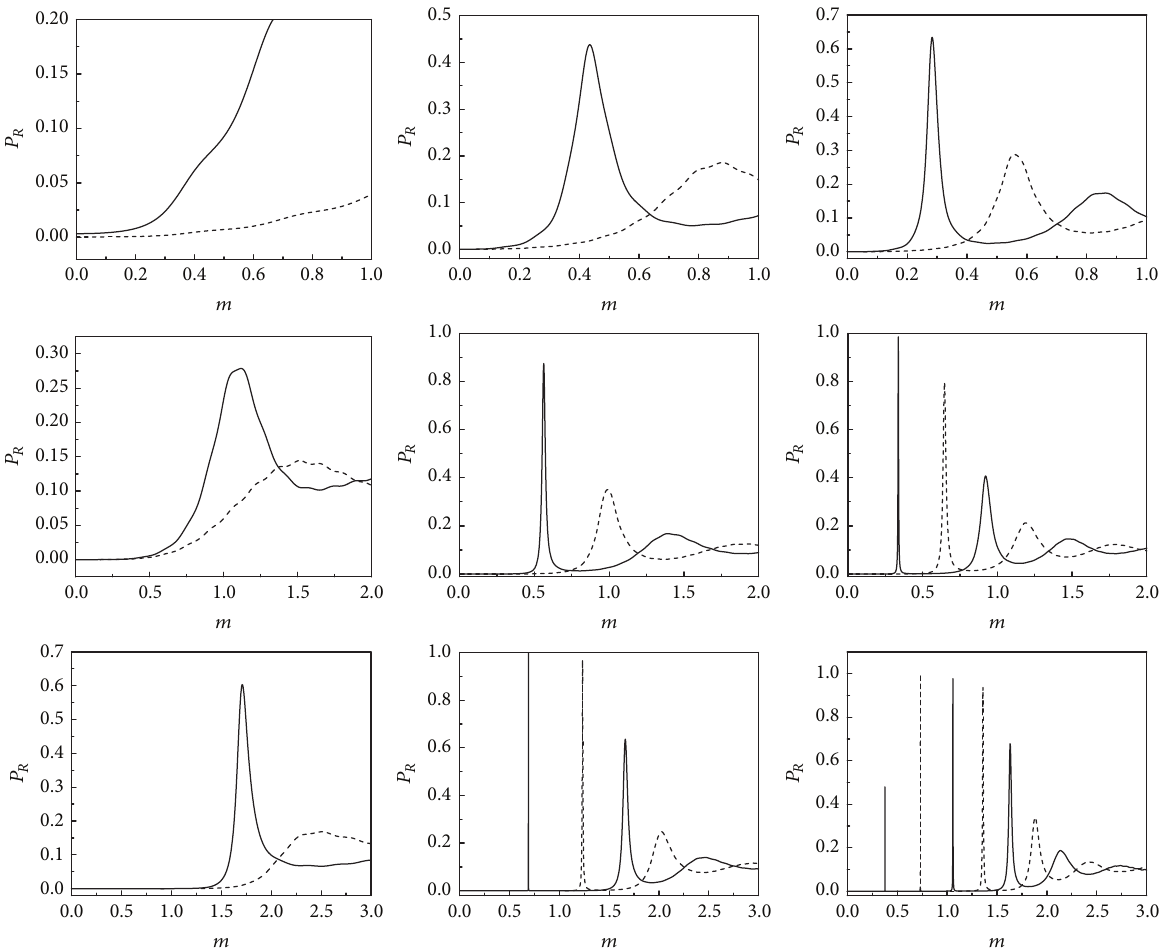
Figure 5: Plots of relative probability for right-handed fermion resonances with 𝑎 = 1.0 (left column), 𝑎 = 3.0 (middle column), and 𝑎 = 5.0 (right column). Coupling constants are 𝜂 = 0.5 (first raw), 𝜂 = 1.0 (second raw), and 𝜂 = 2.0 (third raw). Solid lines and dashed lines correspond to even and odd parity, respectively. In all cases 𝜆 = 1.0 .